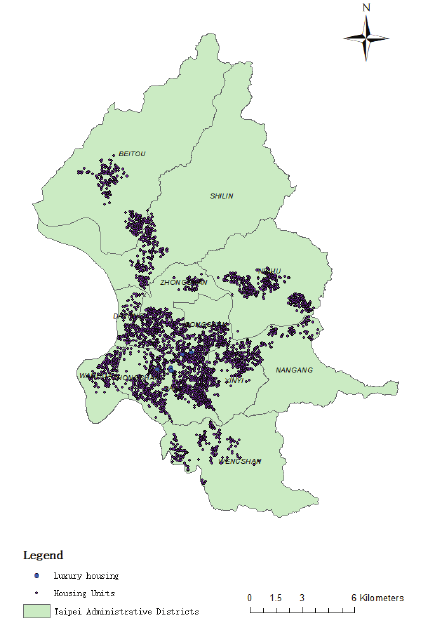
Figure 2. Luxury housing cases in Taipei City and housing